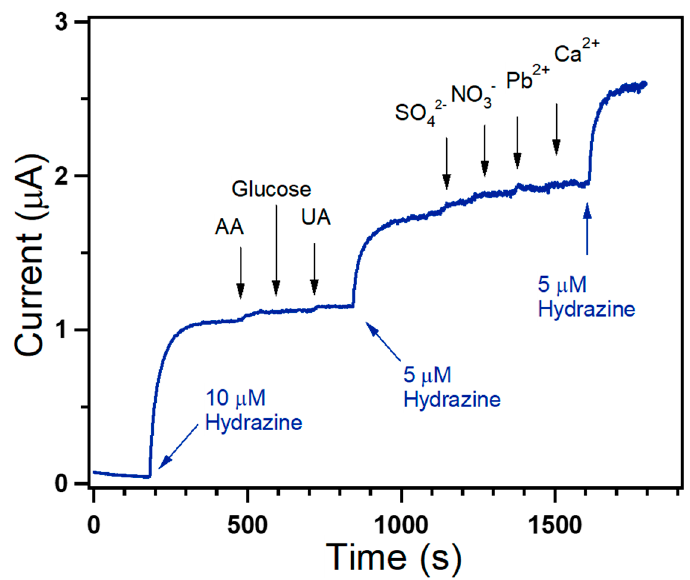
Figure 7. Amperometric (i–t) measurement showing the interference behavior of the Fe-doped TiO 2 coated GCE upon the successive injections of 10 or 5 µ M hydrazine and each 100 µ M of AA, glucose, UA, SO 42 − , NO 3 − , Pb 2 + and Ca 2 + into a continuously stirred 0.1 M PBS (pH 7.4) solution operating at +0.45 V vs. Ag/AgCl. Table 1. Comparison of the sensor parameters of the Fe-doped TiO 2 coated GCE sensor with some recently reported hydrazine electrochemical sensor materials.